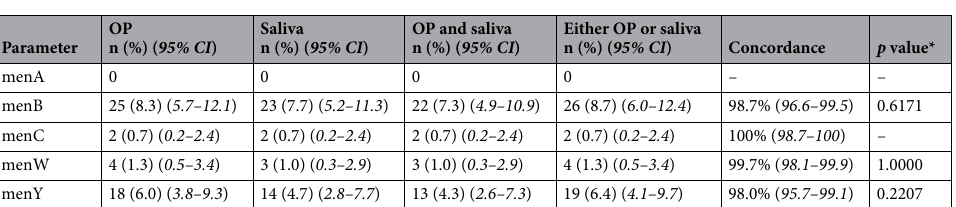
Table 3. Prevalence of meningococcal MenACWY vaccine-type serogroups among OP and saliva samples collected from students (n = 299) and tested by qPCR. * p values are calculated from McNemar tests comparing students positive for serogroup in oropharyngeal samples and saliva samples. The percentage of concordance displays the proportion of samples (n = 63) with identical result in serogroup-specific qPCR assay for a particular